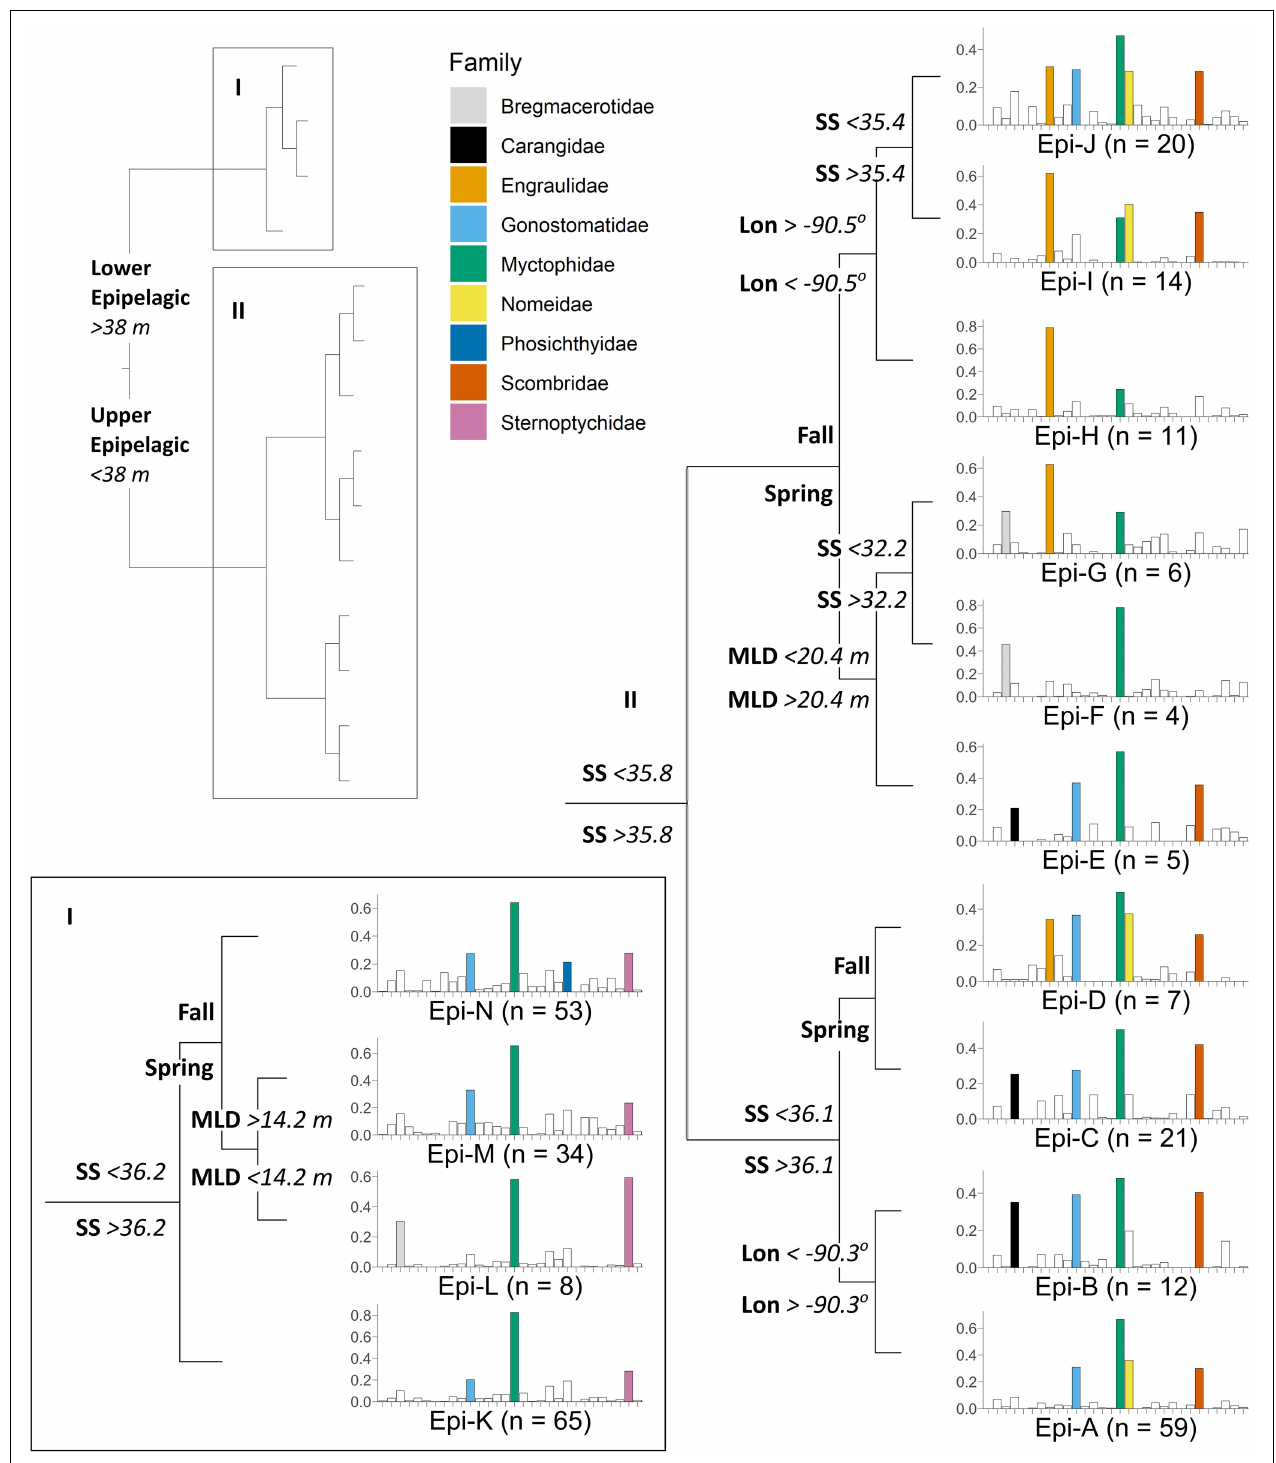
FIGURE 4 | Multivariate regression tree illustrating the effect of depth, surface salinity (SS), season (fall/spring), mixed layer depth (MLD), and longitude (Lon) on the structure of epipelagic (0–200 m) larval fish assemblages in the northern Gulf of Mexico. The full tree structure is depicted in the upper left, with (I) lower epipelagic and (II) upper epipelagic branches detailed separately. Each node represents a diverging environmental or spatiotemporal variable, resulting in terminal nodes with distinct assemblage groups (Epi-A – Epi-N). Barplots represent mean square root relative abundance (i.e., Hellinger-transformed larval abundance; y -axis) for each of 30 families ( x -axis) in alphabetical order from left to right (see Table 2 for list of family names), with the most abundant families (abundance > 0.2) in each assemblage group highlighted in color for clarity. Sample size (n) for each assemblage group is indicated next to the group name.